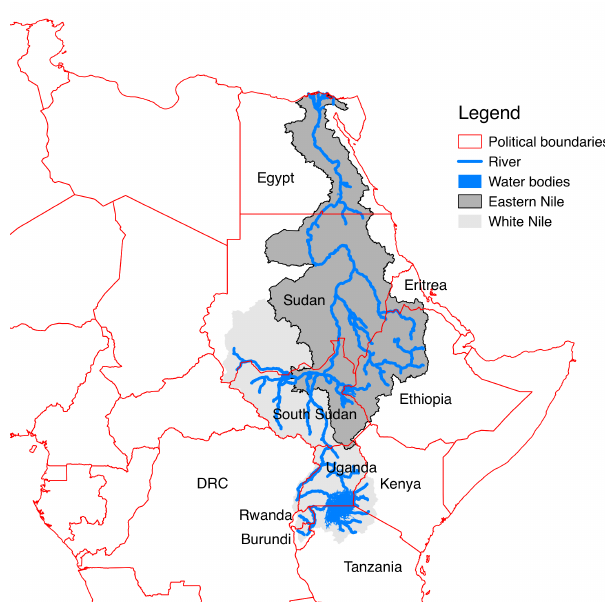
Figure 5. Eastern Nile River basin